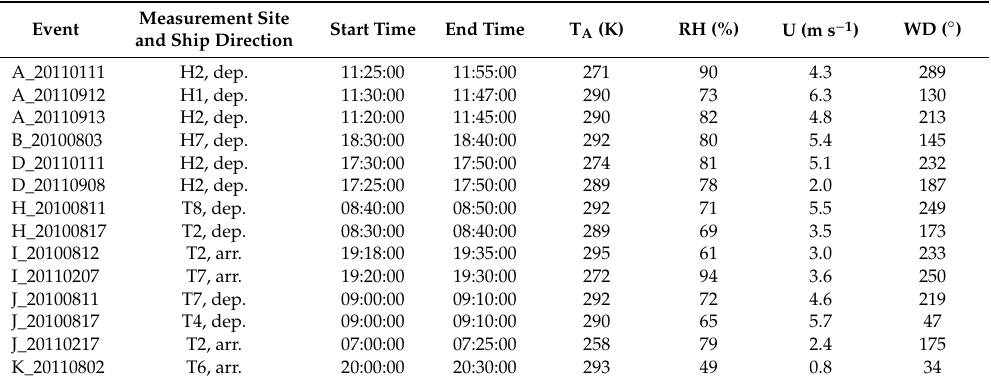
Table 1. Information on the ship events in Helsinki and Turku. Selected average meteorological conditions (air temperature T A , relative humidity RH, wind speed U, wind direction WD) are presented during the ship events. The direction of the ship on the route is indicated by: arr. = arrival; dep. =